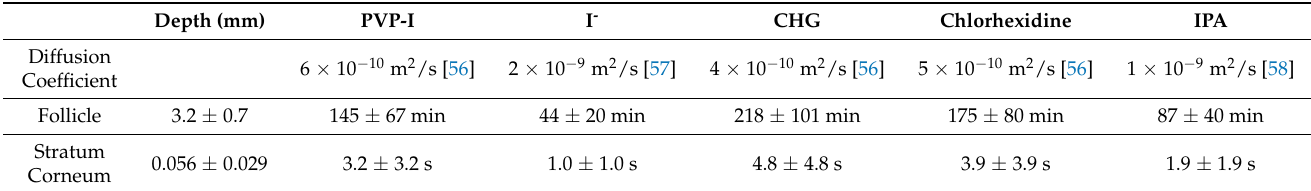
Table 1. Approximate diffusion coefficients and corresponding diffusion times are listed as a compar- ative